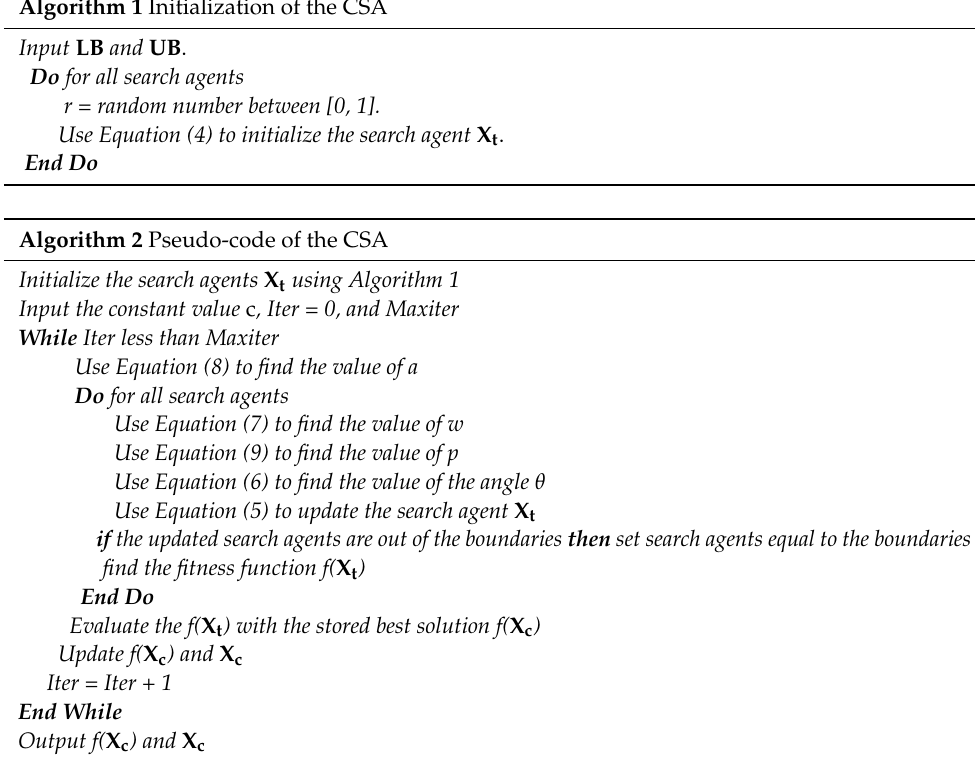
Algorithm 1 Initialization of the CSA